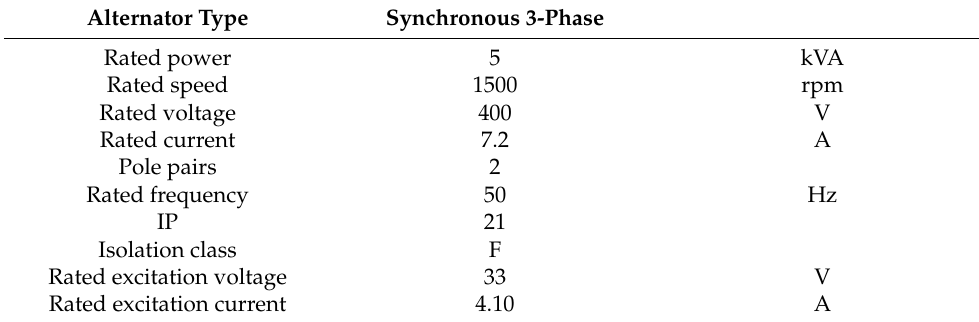
Table 2. Main machine data.